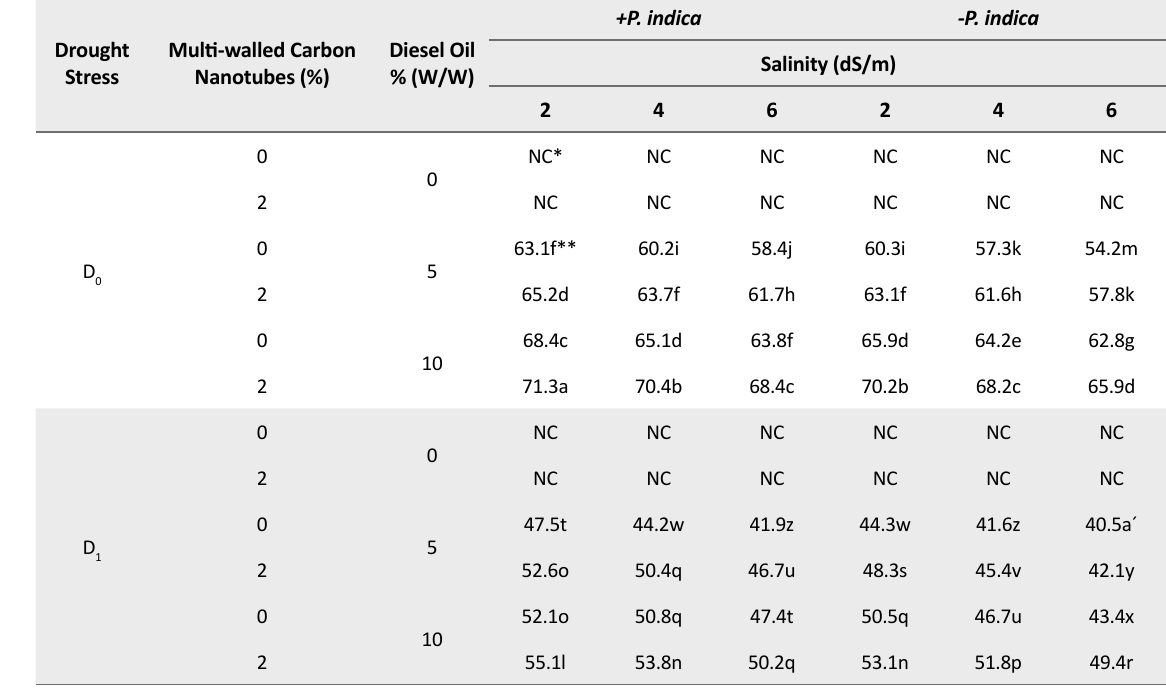
Table 1. The effect of treatments on biodegradation of diesel oil in the soil % (W/W)